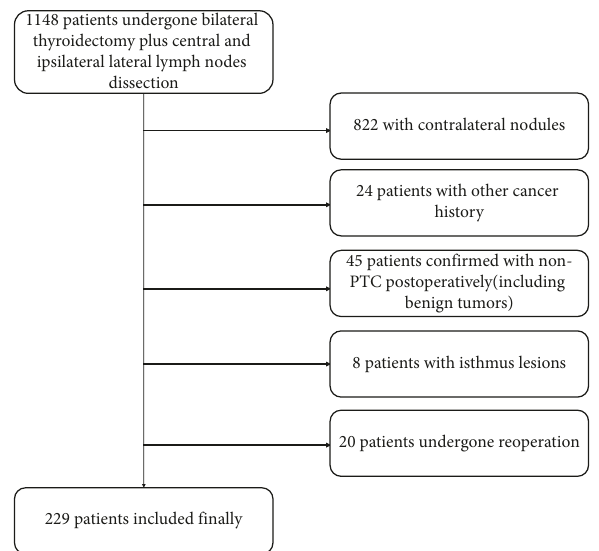
Figure 1: Flowchart illustrating the selection of the